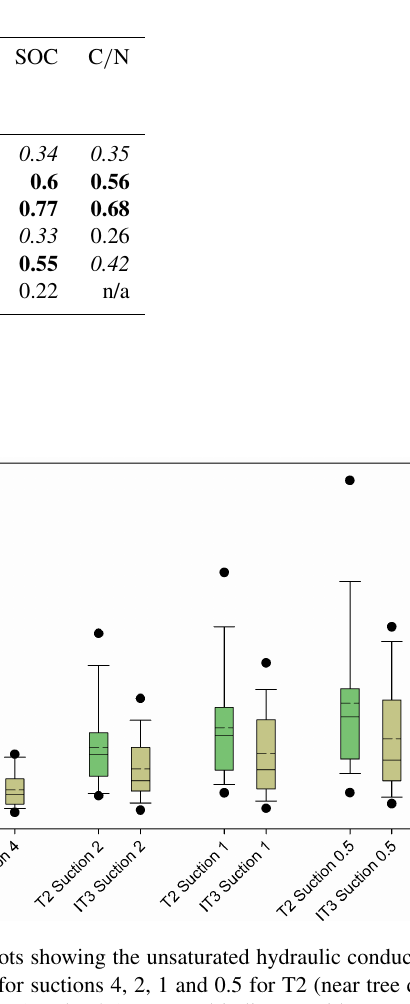
Table 2. Effect sizes (Pearson’s r ) for significant differences ( p < 0.05) between sampling locations for the analysed parameters. Values show the size of the effect, if significantly different. n/a – not applicable or no significant difference; small effect – ≥ 0.1; medium effect – ≥ 0.3 (in italics); large effect – ≥ 0.5 (bold); EC – electrical conductivity; PS – percolation stability; TN – nitrogen content; SOC – content of soil organic carbon; C / N is the C / N ratio.